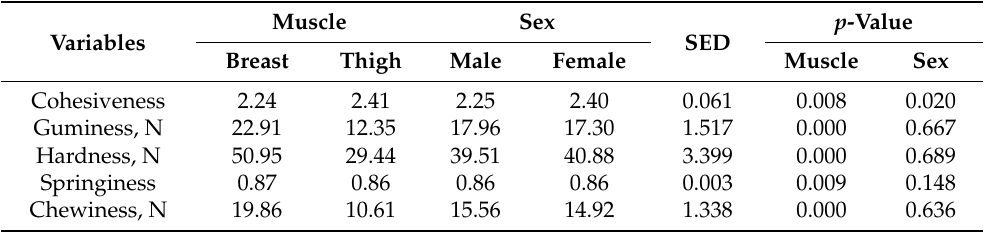
Table 7. Effects of muscle anatomical location and goose sex on parameters of texture profile